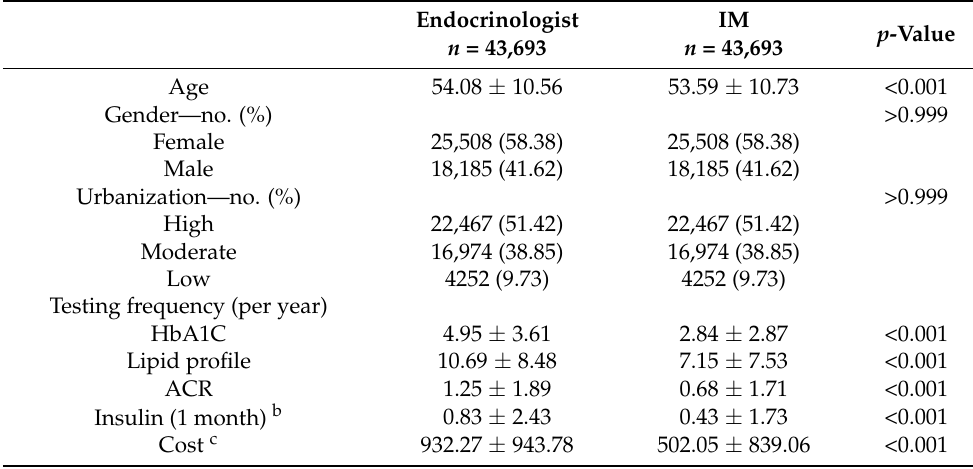
Table 3. Characteristics of the endocrinologist and other internal medicine (IM) cohorts a